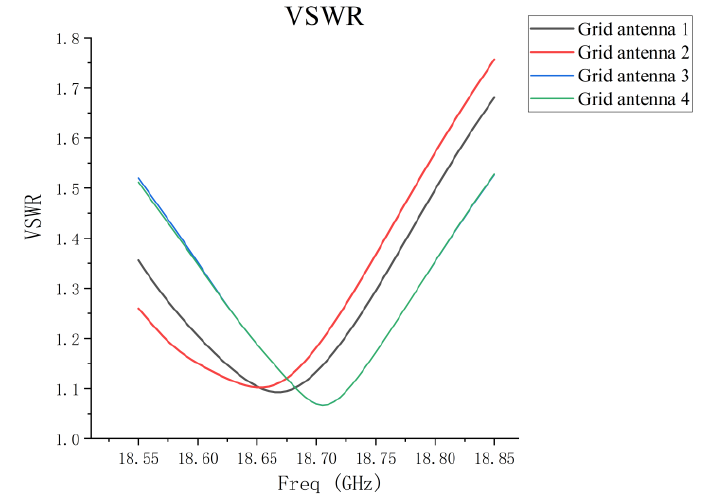
Figure 6. Simulated VSWR of four grid antennas in one-dimensional non-redundant sparse array.